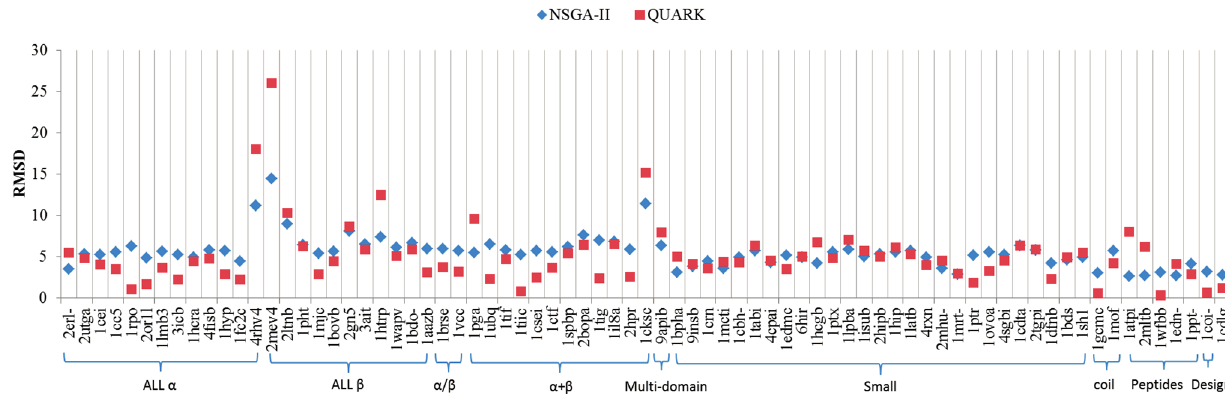
Figure 2. Comparison of the proposed approach with the